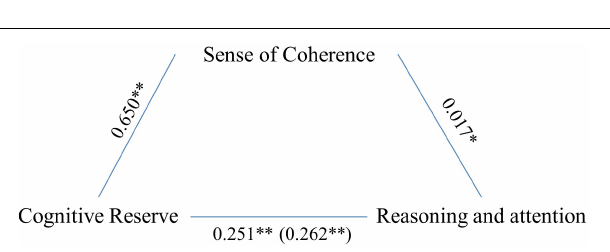
FIGURE 1 | Sense of coherence (SoC) as a partial mediator of the association between CR and verbal memory. Values are B coefficients (* p < 0.05; ** p < 0.01); values within parentheses represent total relationship.